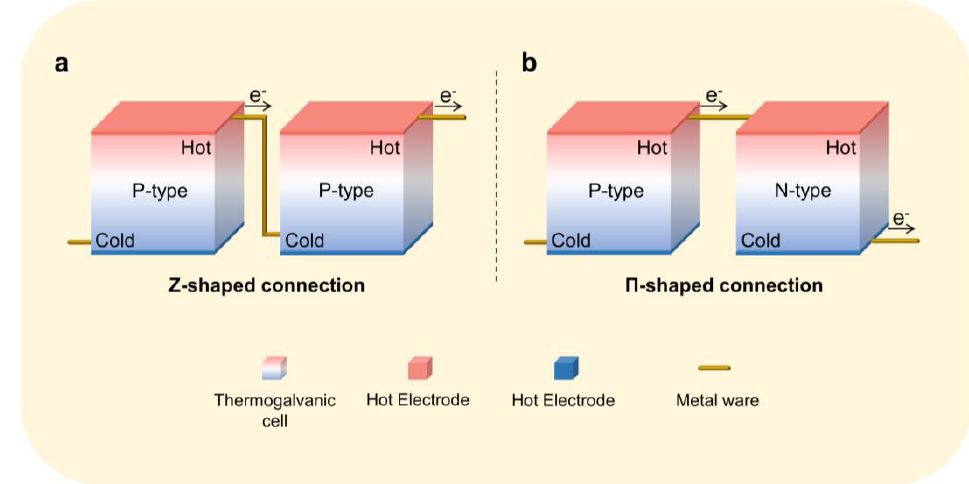
Figure 10. ( a ) Z-shaped connection for a cell. ( b ) Π -shaped connection for a cell.